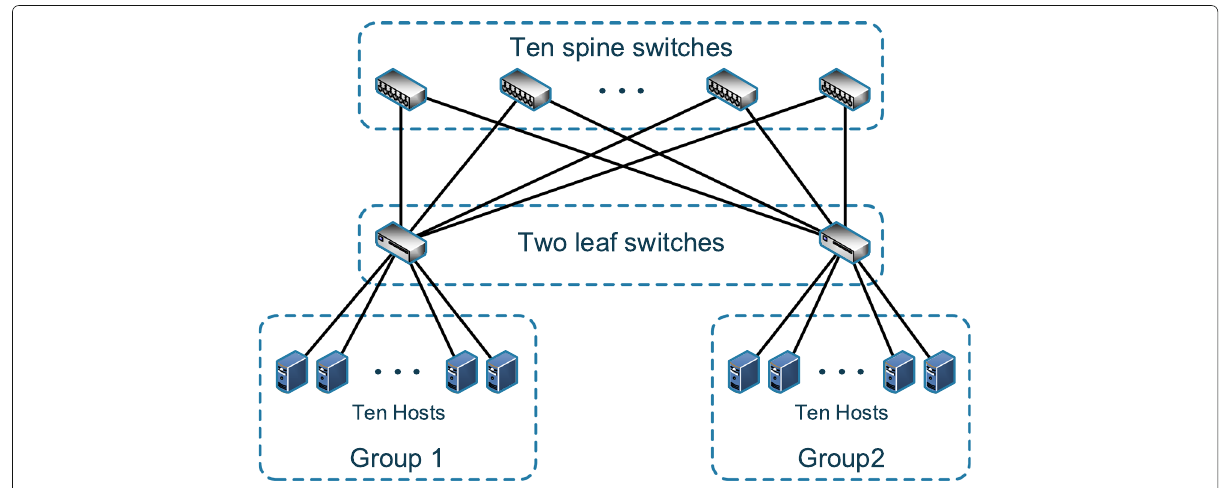
Fig. 1 The leaf-spine topology